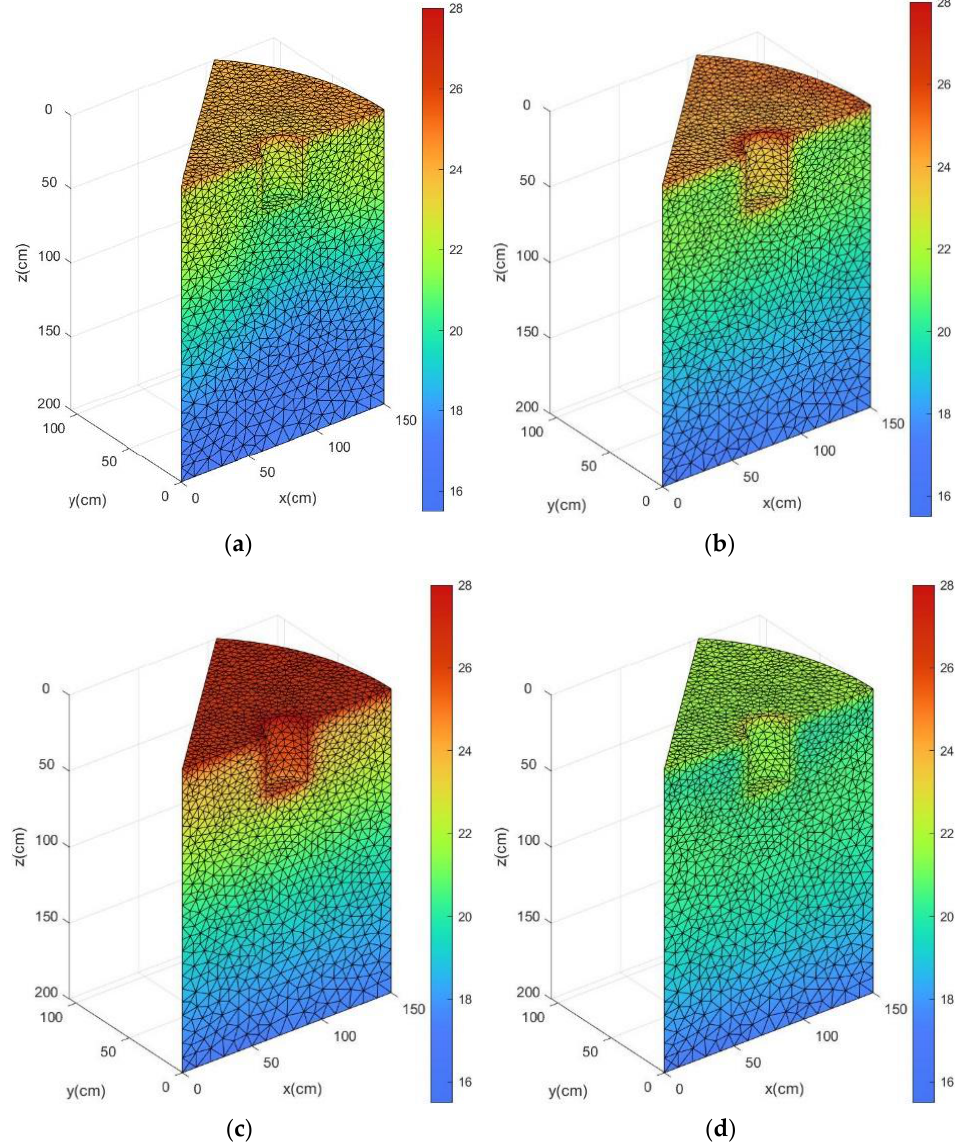
Figure 10. Simulation of soil temperature distribution on different days. ( a ) Soil temperature after 1 day of irrigation; ( b ) Soil temperature after 5 days of irrigation; ( c ) Soil temperature after 11 days of irrigation; ( d ) Soil temperature after 17 days of irrigation. Table 7. Calculation of the statistical indexes of daily soil temperature for water storage pit irriga- tion.